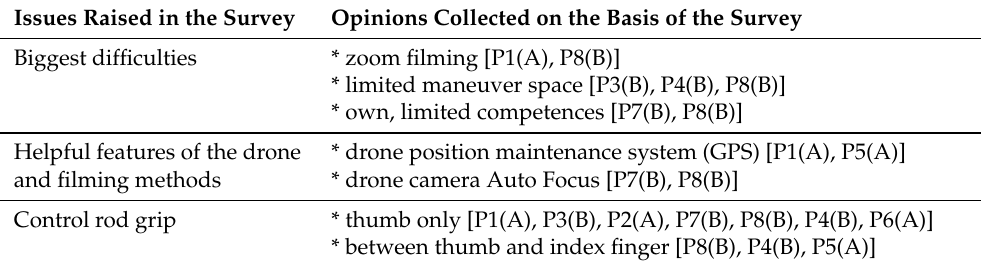
Table A1. Comparison of results of a survey; Source: own study. Issues Raised in the